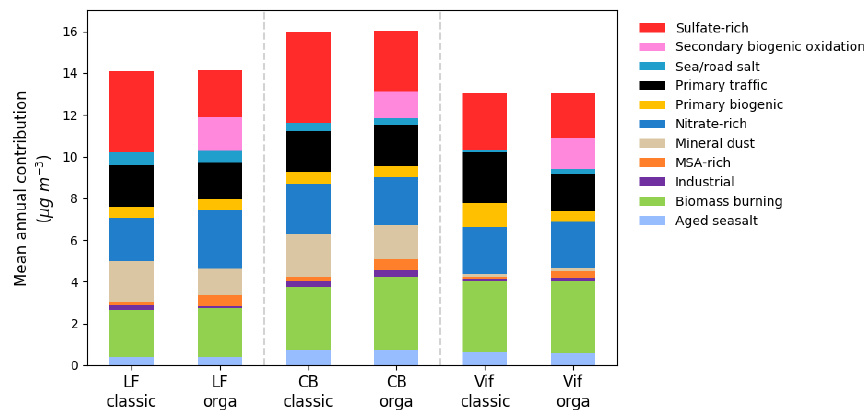
Figure 7. Mean annual contribution (µgm − 3 ) of PMF-resolved factors of PM 10 in the Grenoble basin using a classic set of input variables similar to SOURCES (“classic”) and using additional new organic tracers